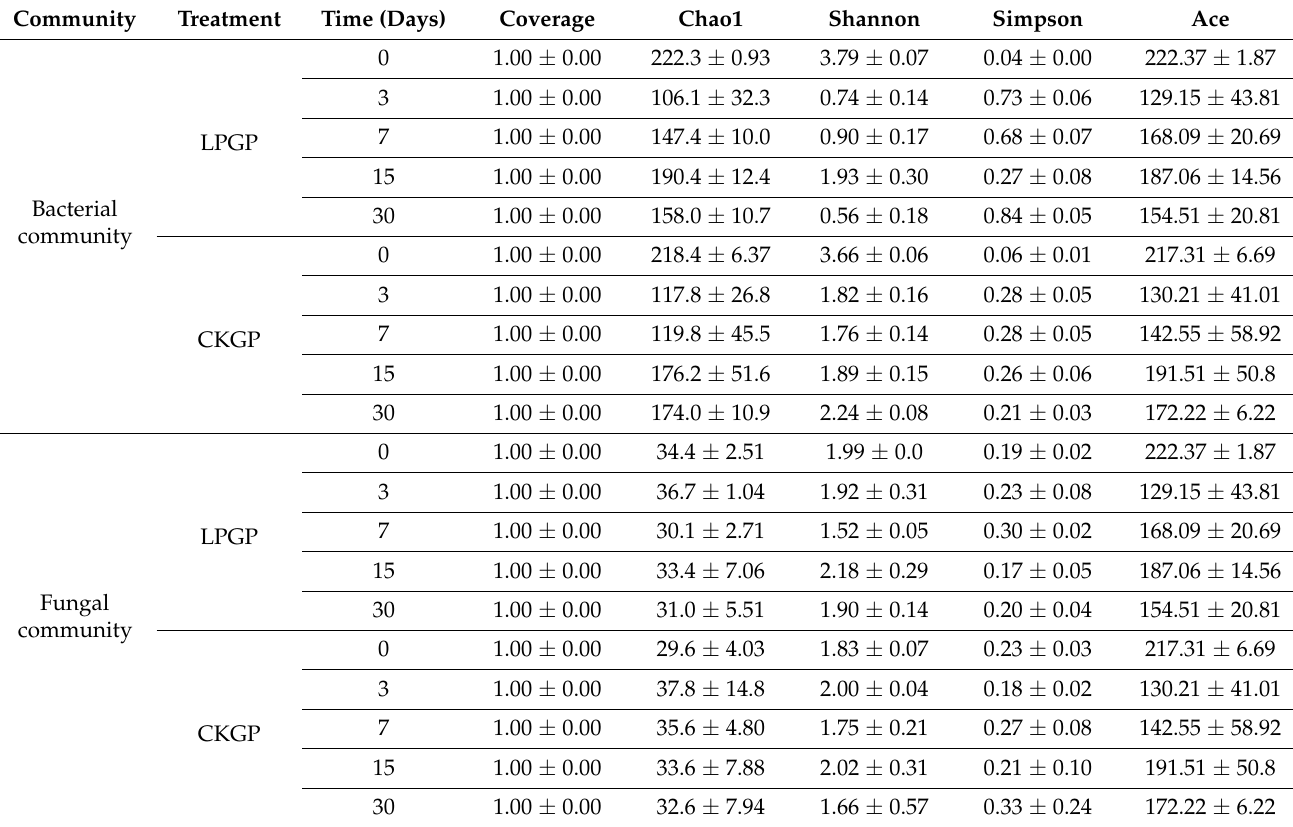
Table 5. Alpha diversity of bacterial and fungal community during the